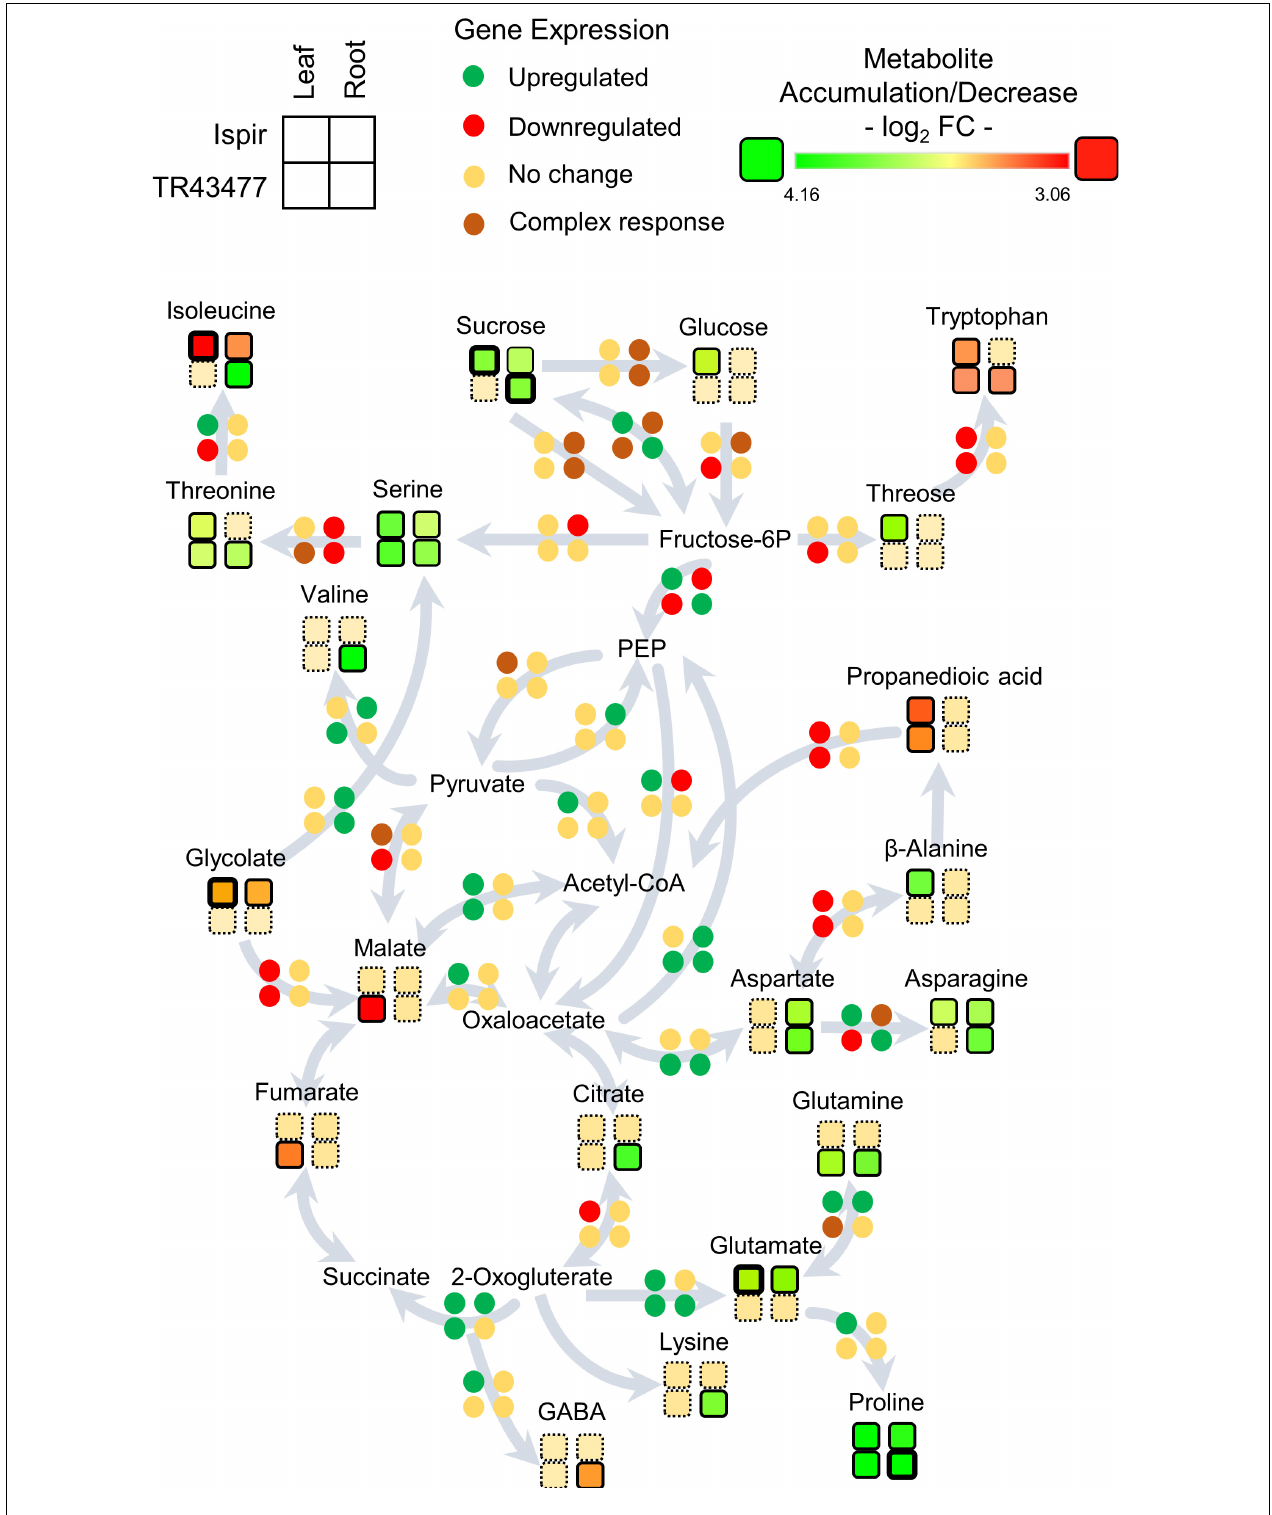
FIGURE 6 | Representation of the transcript and metabolite changes in carbon and amino-acid metabolism in root and leaf tissues of both genotypes in saline conditions. The pathway map was derived from KEGG database. Disk units for gene expression represent one or more genes depending on the pathway: Detailed list of the relevant genes can be found in Additional file 3 ; Primary Metabolism tab. Rows represent genotypes and columns represent tissues. Bold outlines indicate high significance with a p -value < 0.01.